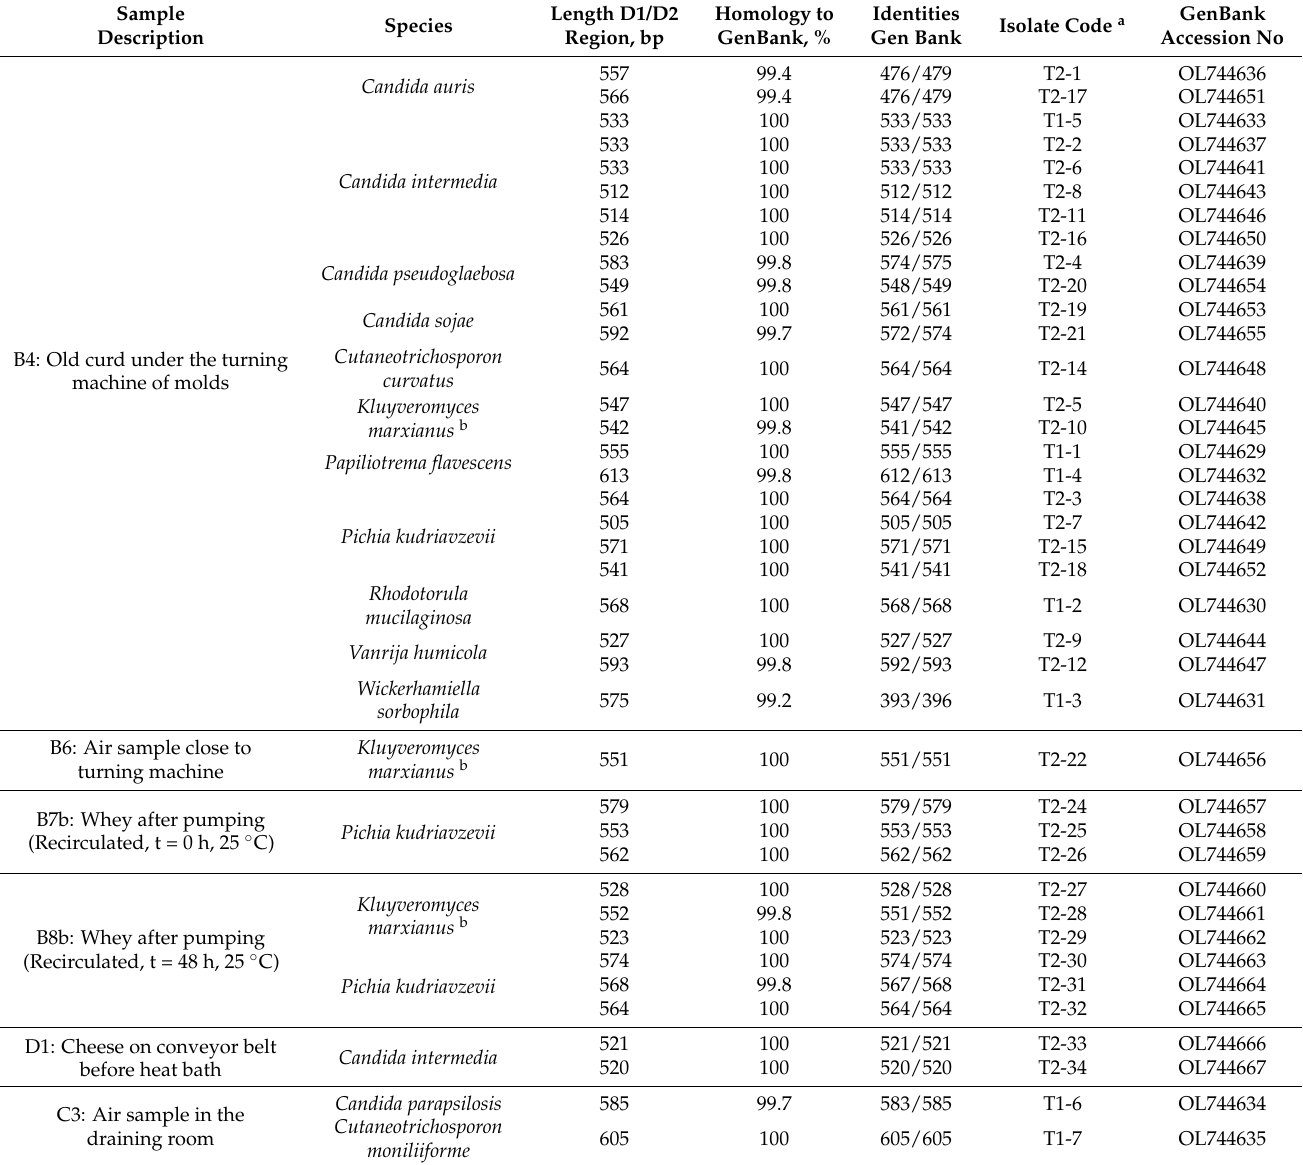
Table 3. Identification of yeasts from the white-brined cheese production by sequencing the D1/D2 region of the 26S rRNA